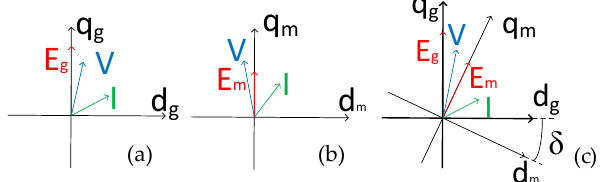
Figure 3. Park’s reference frames: ( a ) generator voltage and current vectors in the generator reference frame ( d g , q g ); ( b ) motor voltage and current vectors in the motor reference frame ( d m , q m ); ( c ) generator and motor voltage and current vectors with phase shift in the generator reference frame ( d g , q g ).